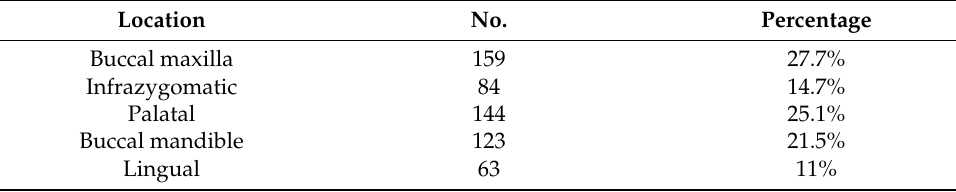
Table 2. Distribution of the mini-implants according to the insertion site. Location No. Percentage Buccal maxilla